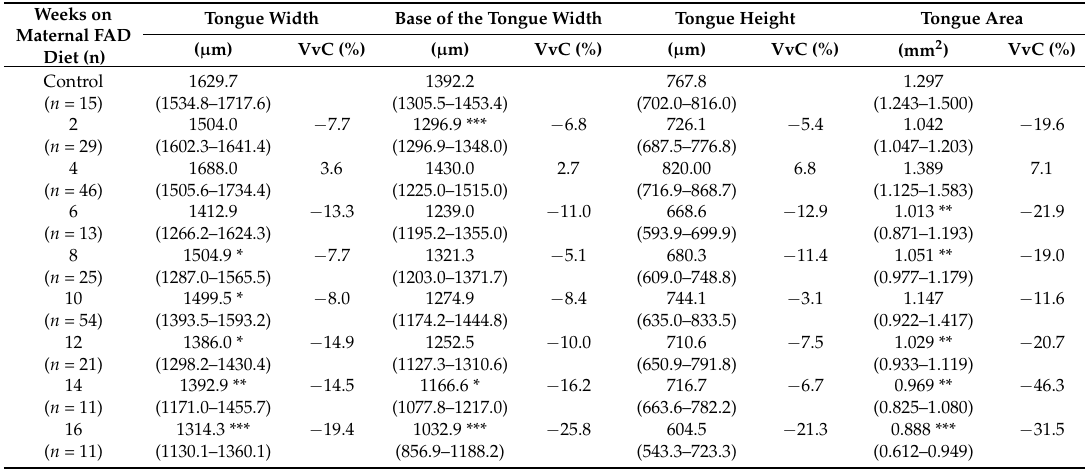
Table 3. Effects of folate deficiency on tongue measurements.